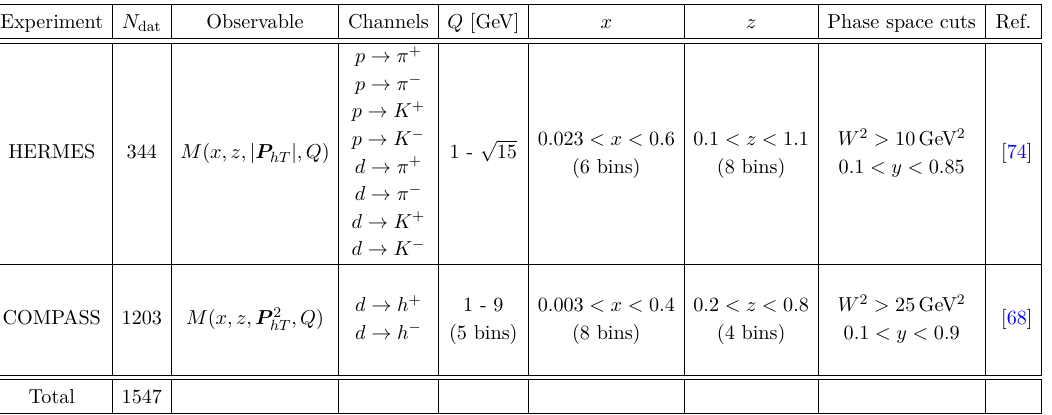
Table 3 . Breakdown of the SIDIS datasets included in this analysis. For each dataset, the table includes information on: the number of data points ( N observable delivered, the SIDIS channel, the range(s) in photon invariant mass Q , the ranges in the kinematic variables x and z , possible cuts on the single final-state lepton, and the public reference (when available). The total number of SIDIS data points amounts to